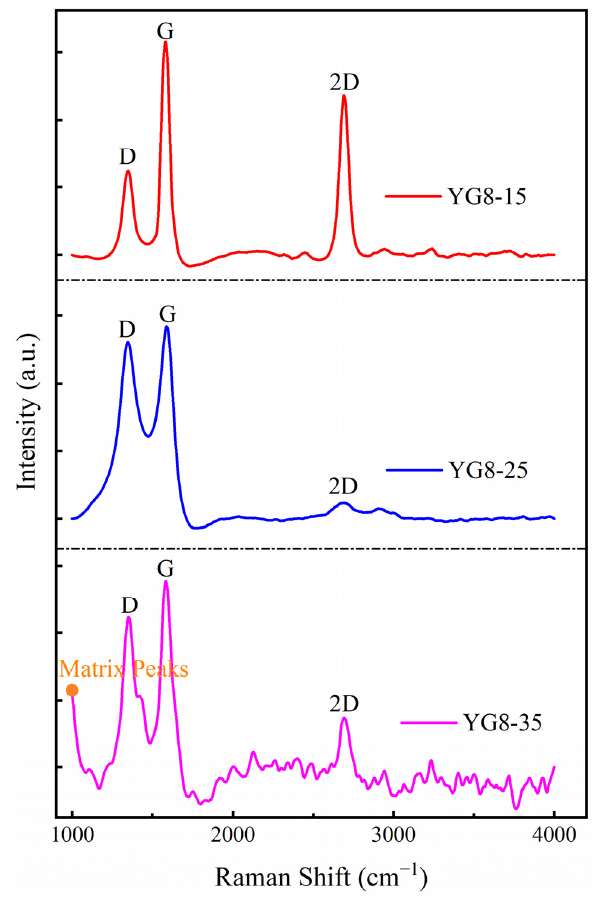
Figure 3. The Raman spectra at different cooling rates.